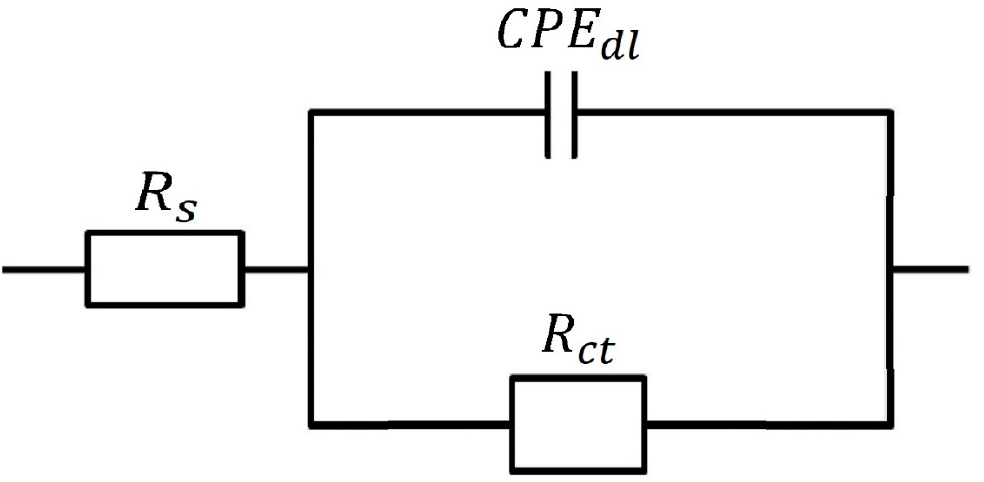
Figure 9. The equivalent circuit model was used to fit the experimental data.